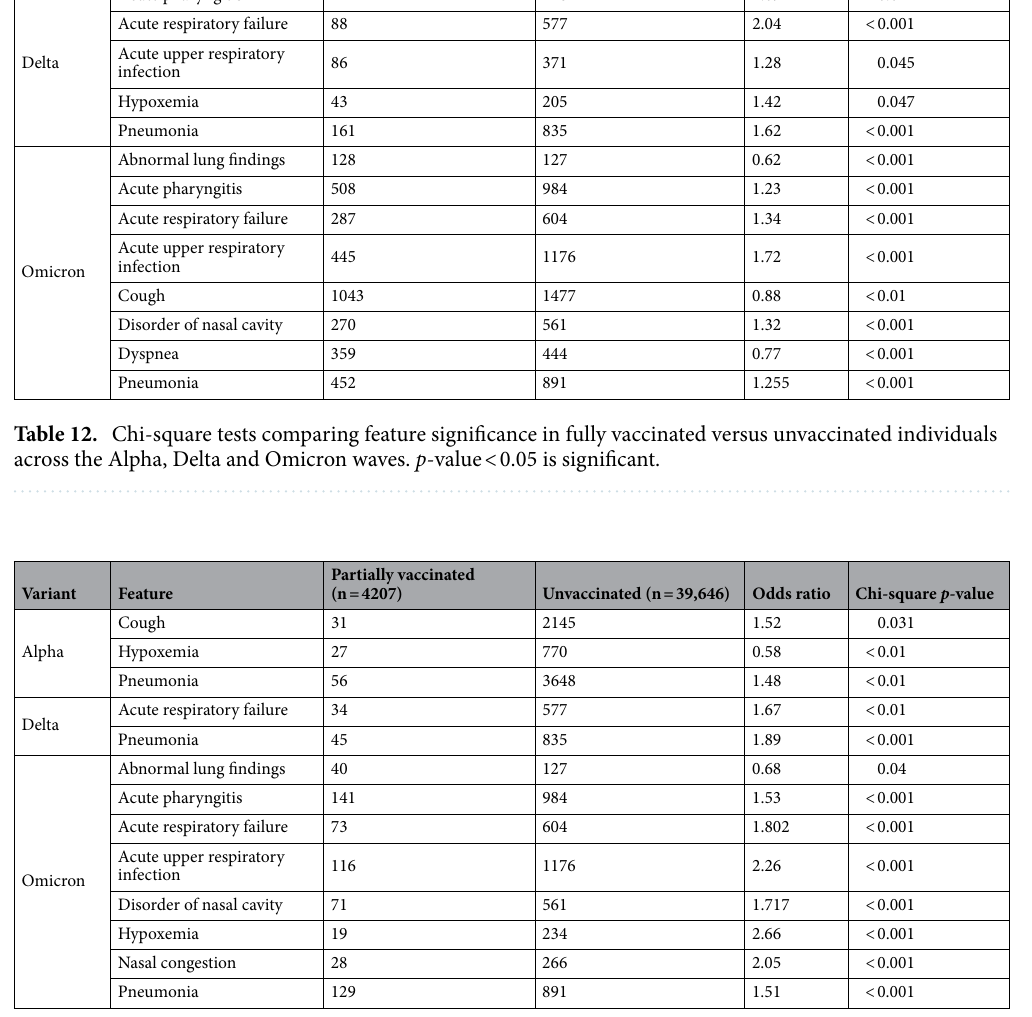
Table 13. Chi-square tests comparing feature significance in partially vaccinated versus unvaccinated individuals across the Alpha, Delta and Omicron waves. p -value < 0.05 is significant.